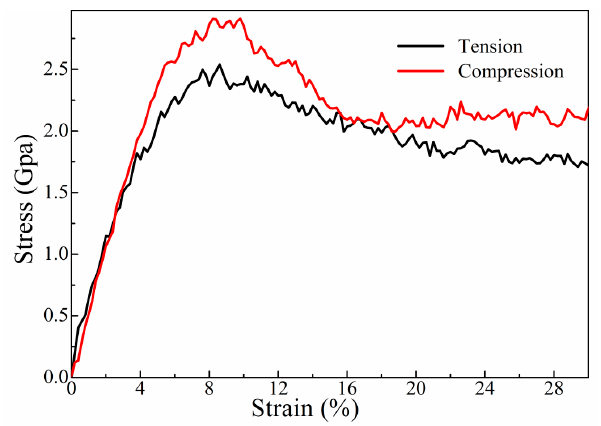
Figure 2. (Color online) The MD simulated uniaxial stress-strain curves of the Zr 2 Cu structural model under tension (Black solid line) and compression (Red solid line).